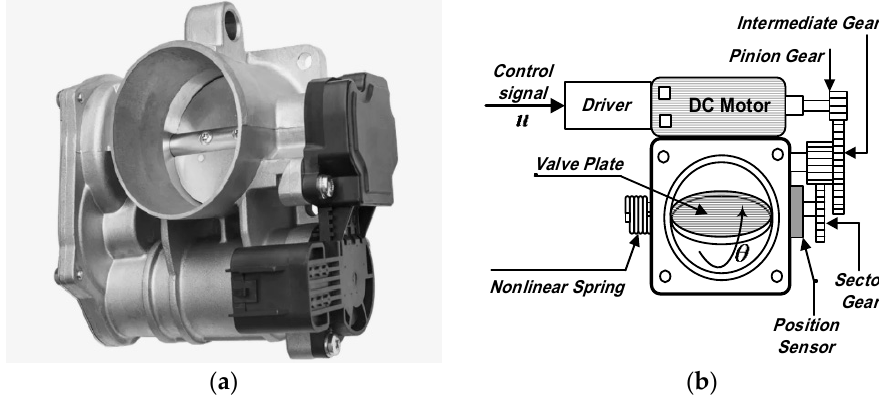
Figure 1. Electronic throttle valve ( a ) Actual Throttle Valve ( b ) Schematic Throttle valve.